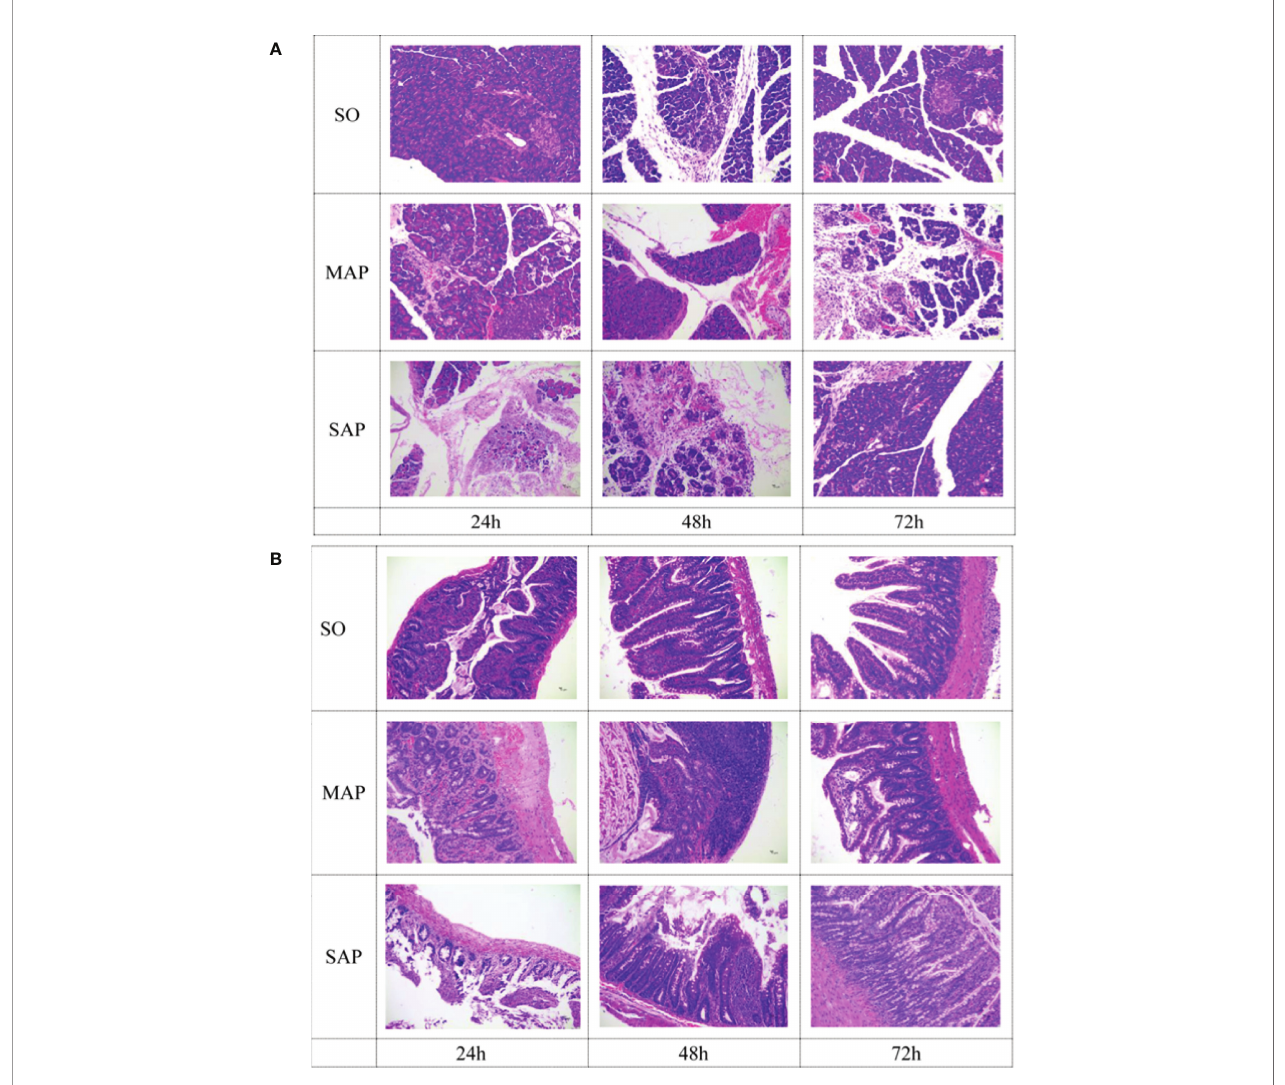
FIGURE 1 | Histological examination of the pancreas (A) and small intestine (B) samples taken at three time points. SO, Sham operation; MAP, Mild acute pancreatitis; and SAP, Severe acute pancreatitis. Magni fi cation: